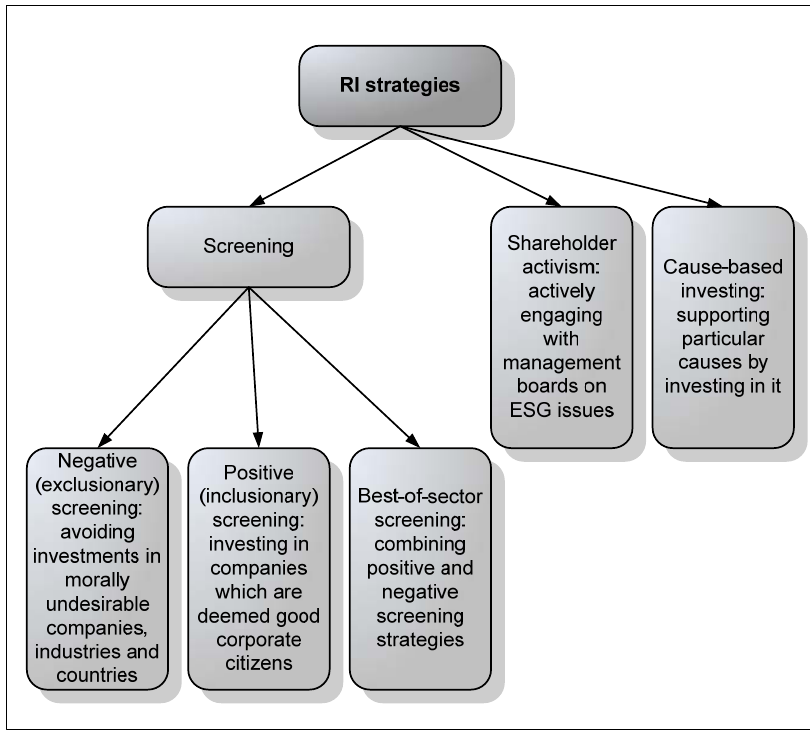
Figure 1: Prominent RI strategies Source: Researchers’ own